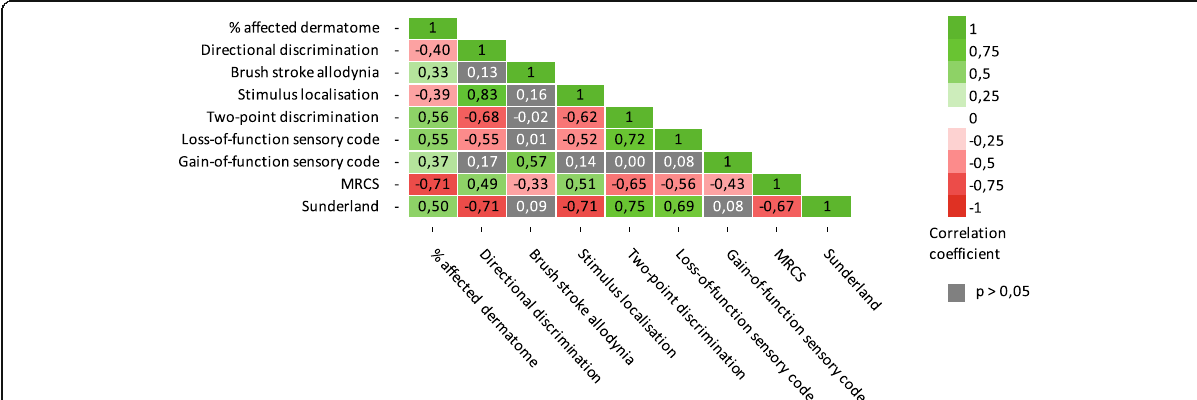
Fig. 1 Correlation between objective neurosensory measurements. Correlation coefficients of significant positive correlations ( P < 0.05) are shown in green. Correlation coefficients of significant negative correlations ( P < 0.05) are shown in red. Non-significant correlations ( P < 0.05) are displayed in grey. Neurosensory tests consisted of percentage of affected dermatome, directional discrimination, the presence of brush stroke allodynia, stimulus localization, two-point discrimination, sensory phenotype loss- and gain-of-function, MRCS, and Sunderland score